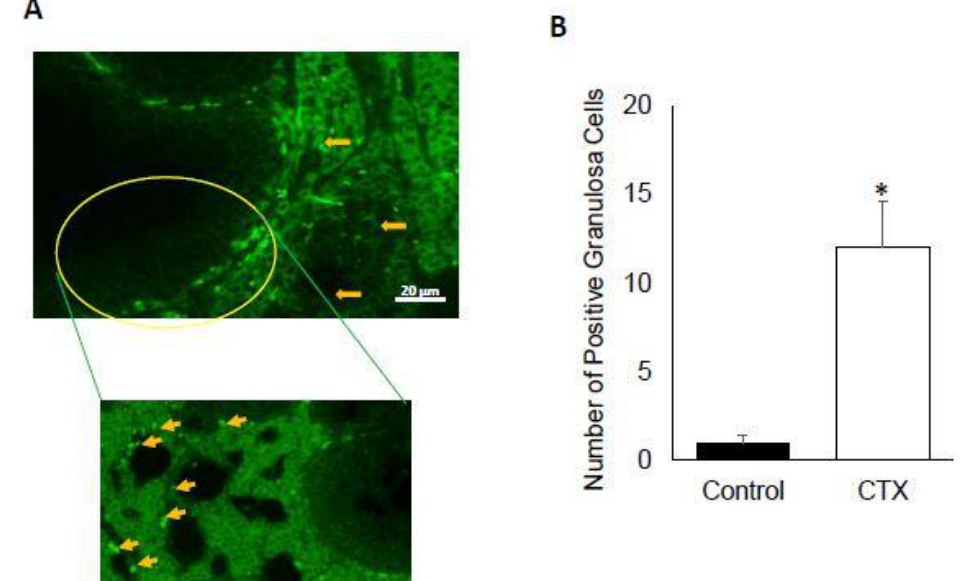
Figure 2. Impact of chemotherapy on apoptosis in murine granulosa cells. ( A ) Tunel staining (green) on ovary cut section, positive staining showed by yellow arrows. Data supported by high magnification of the circle area; ( B ) graph bar of tunel positive granulosa cells number compared to the matched control (* p < 0.05).